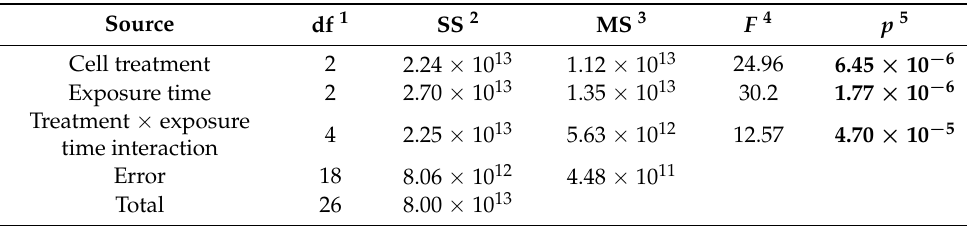
Table 1. Two-way ANOVA of effects of cell treatment (no bead, unloaded resin bead, and the resin bead loaded with 22.7% ( w / w ) Ag nanoparticles) and exposure time on the growth of E. coli B over three hours. Source.